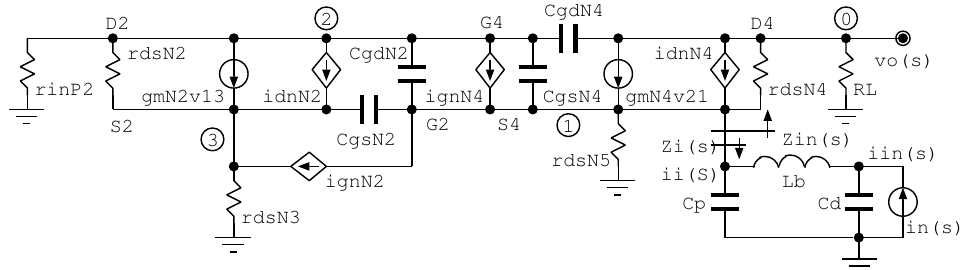
Figure 4. Simplified small-signal model of the preamplifier stage, including noise current sources of transistors MN 2 and MN 4. By the Kirchhoff’s voltage equations in nodes 0, 1, 2 and 3, the transimpedance transfer function is obtained (see Appendix